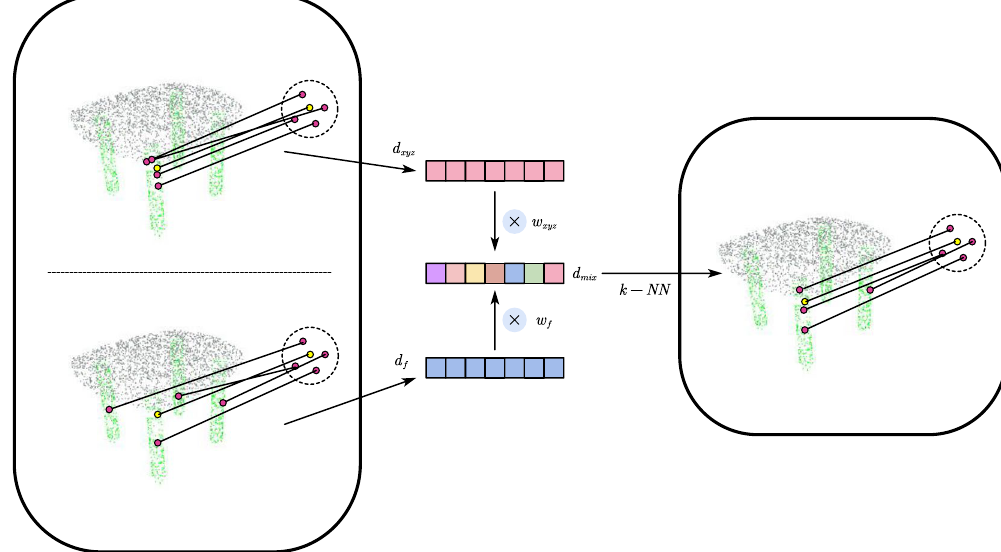
Figure 1. Neighborhood search illustration. Left top: using the distance in 3D space as the search metric. Left bottom: using the distance in feature space as the search metric. Right: The proposed method weights the two metrics by learning from point attention features, then searches the neighborhood using the “mixed” distance. With this method, a point’s neighborhood in the point cloud can be flexibly searched.